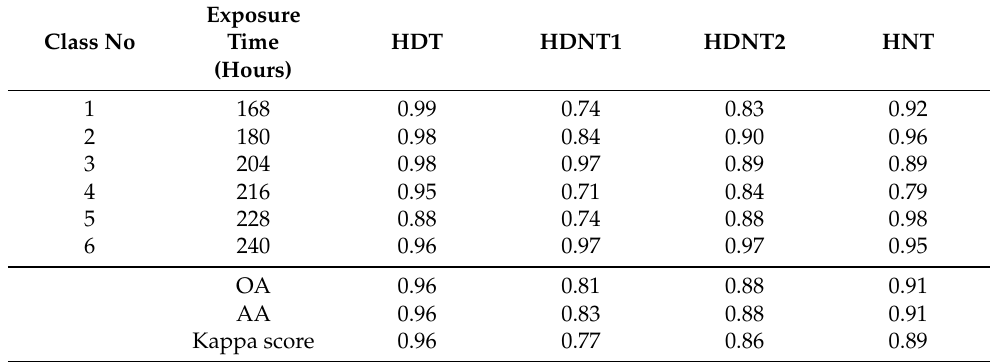
Table 11. Classification performance for rice HSI datasets for different exposure